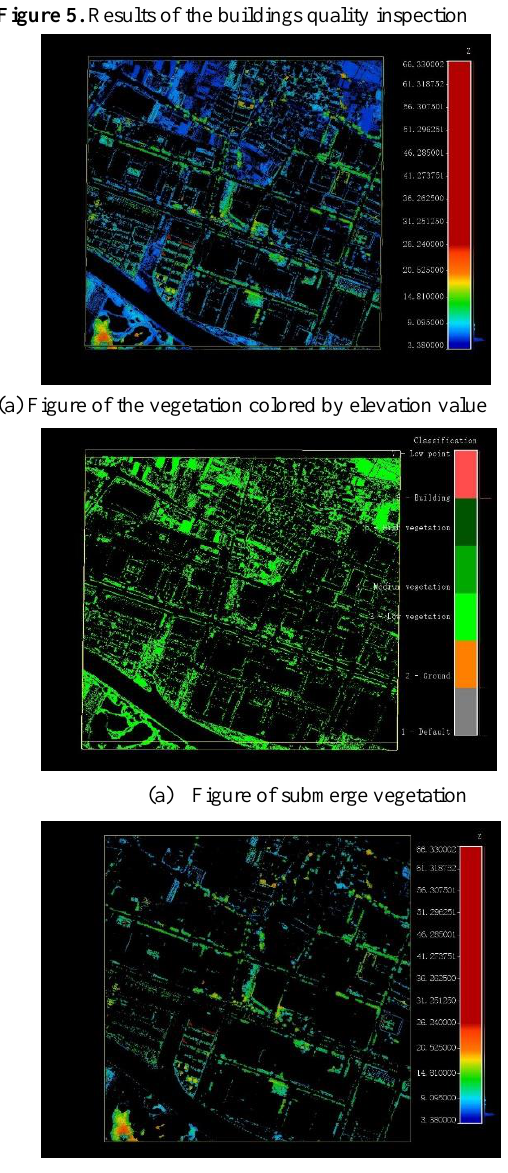
(b) Figure of woodland